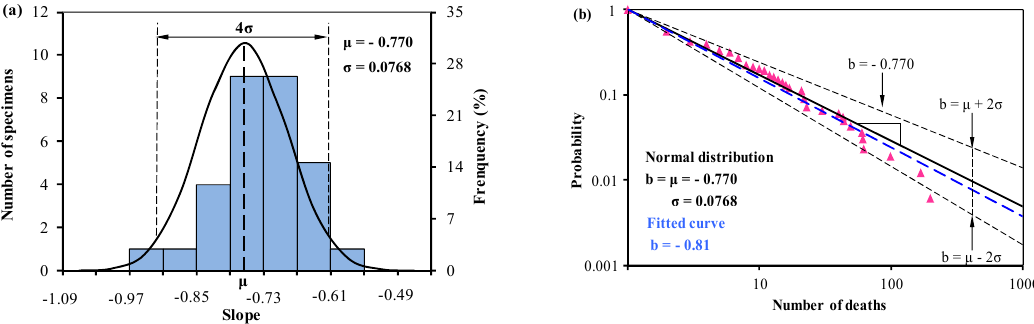
Figure 1. ( a ) Normal distribution analysis of the slope b i determining the relation between the accumulated frequency and number of deaths, and ( b ) predictions from Equations (1) and (3) based on the normal distribution analysis of b i in ( a ) together with the statistical data in road accidents from 1931 to 2004 digitized from Oggero et al. [11].